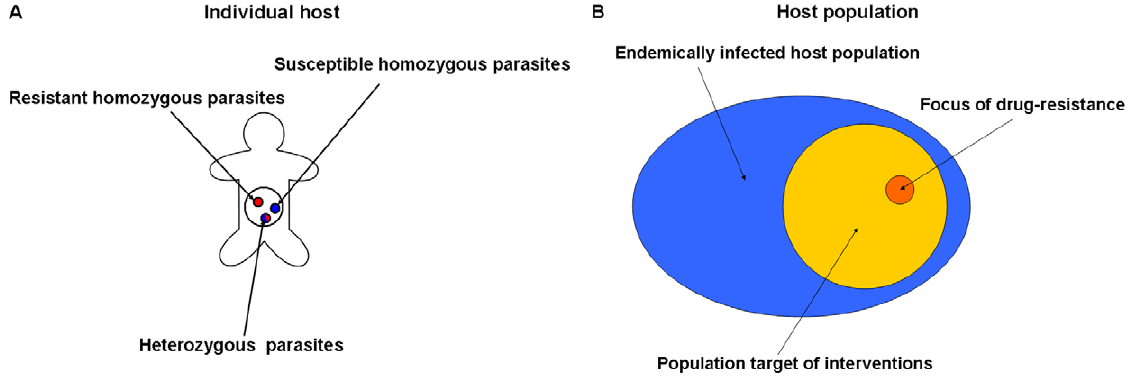
Figure 1. Nested Host-Parasite-Gene populations. A) A host may carry susceptible and resistant parasites, a parasite can be either homozygous or heterozygous for the gene associated with resistance; B) Euler diagram of the host population. Alleles associated with drug resistance are initially concentrated within a sub-set (focus) of the host sub-population (target) that receives either annual chemotherapy or chemotherapy and vaccine every T (e.g. every 5) years.